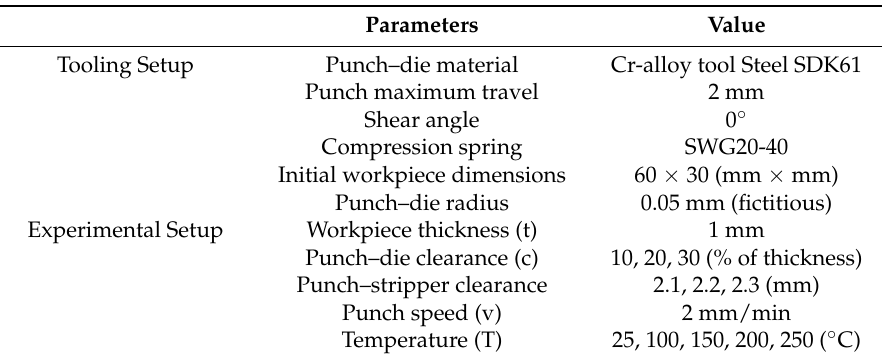
Table 2. Tooling and experimental